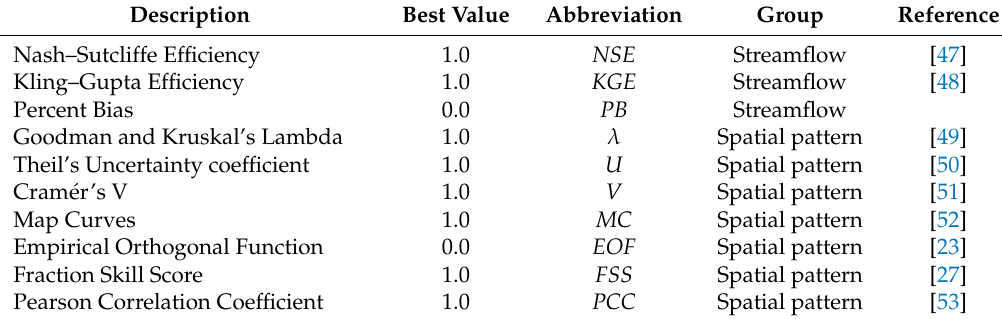
Table 3. Overview of the 10 metrics which were used in the sensitivity analysis. The first three metrics were regarding time series of streamflow, while the latter seven were used to evaluate spatial patterns of